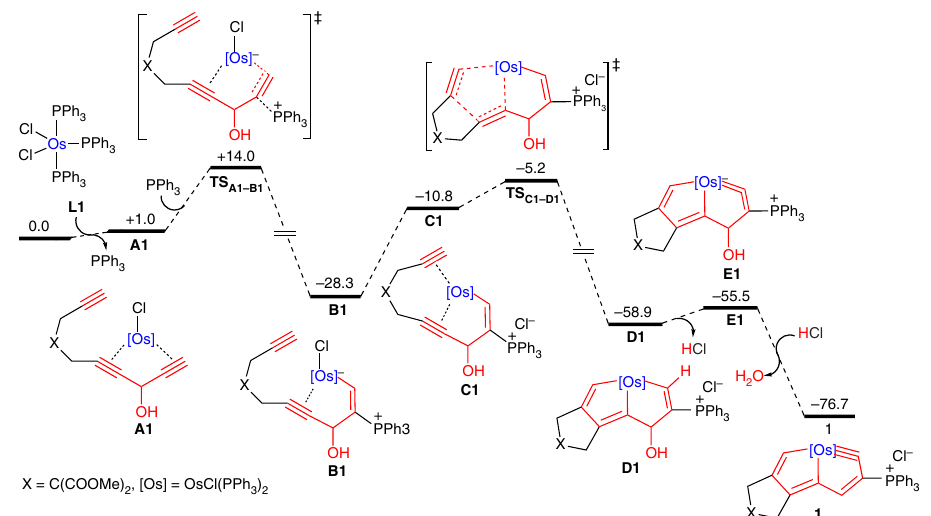
Fig. 7 Gibbs free energy pro fi le for the DFT-calculated formation mechanism of complex 1 at 298 K. The computed free energies are in kcal/mol